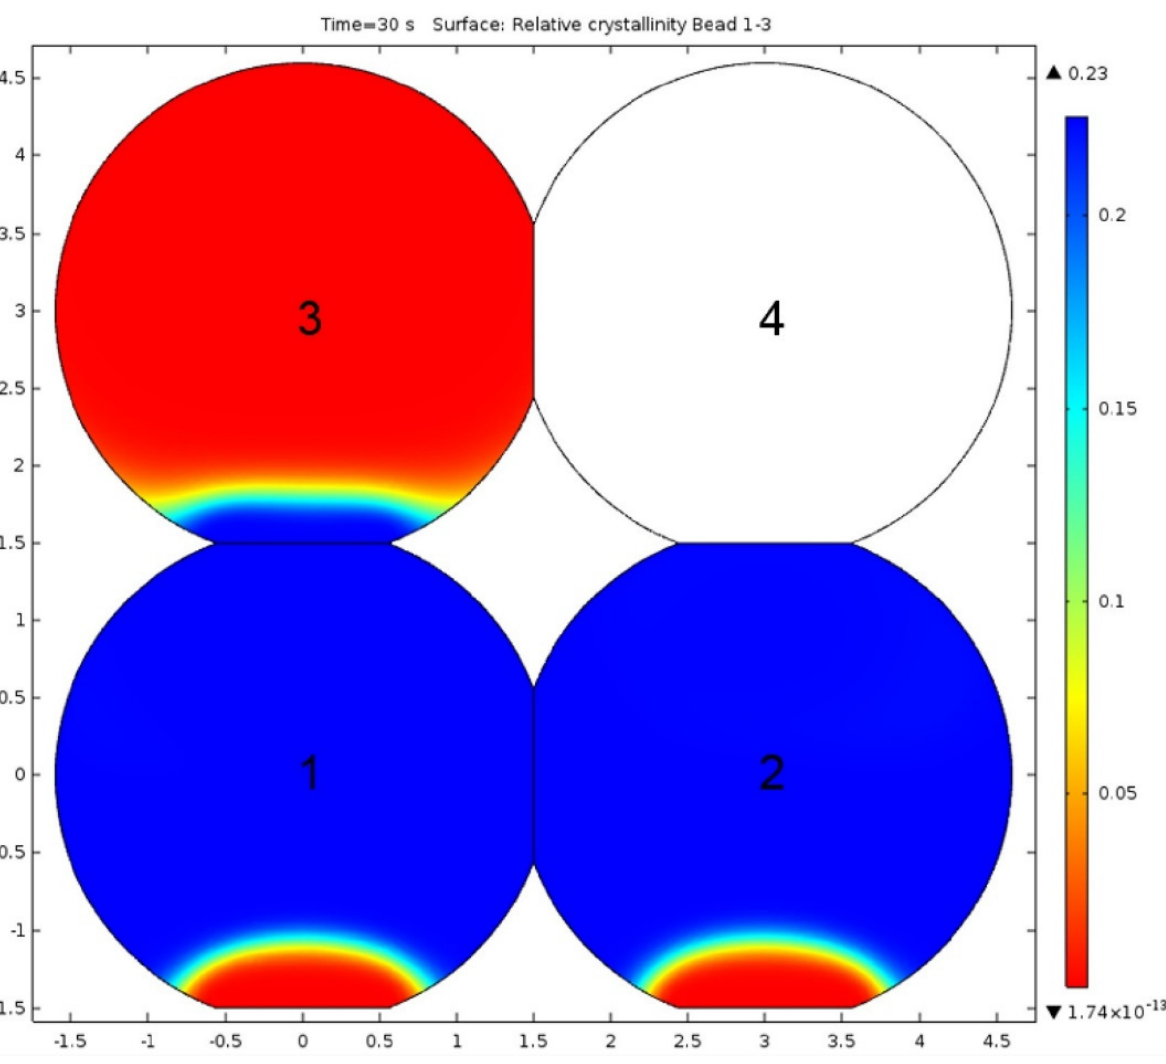
Figure 6. Modeled crystallinity distribution during a print simulation of a simple 2 by 2 bead cross section. Beads 1–3 are active (deposited), while bead 4 is still inactive. Reproduced with permission from reference [20]. Copyright 2018, Elsevier.